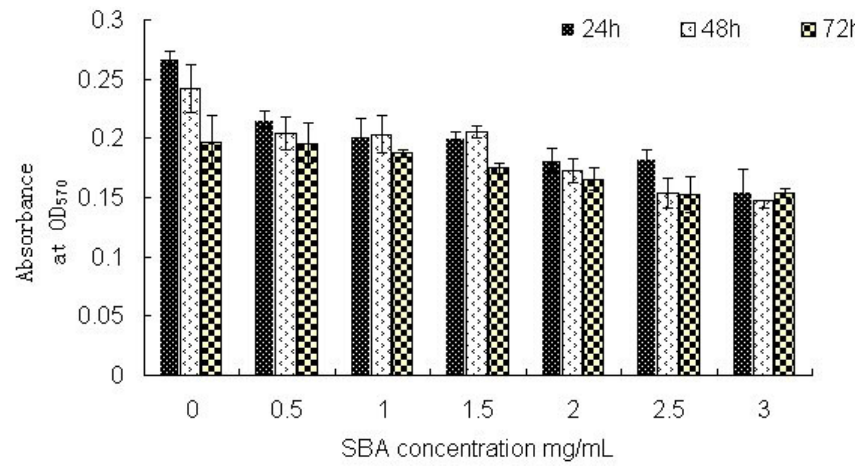
Figure 4. MTT assays showing the viability of IPEC-J2 cells after treatment with different concentrations of SBA for 24 h, 48 h, or 72 h. The data are the mean ± SD from 4 independent experiments and presented a significant decline trend ( p < 0.05). The control group was treated with 0 mg/mL SBA for the indicated times (24, 48, or 72 h). Treatment with 0.5, 1.0 or 1.5 mg/mL SBA resulted in a significant decrease compared with control ( p < 0.05), in addition, 2.0, 2.5 or 3.0mg/mL led to a significant decrease when compared with 0.5,1.0 or 1.5 mg/mL SBA treatment groups ( p < 0.05) (48 h or 72 h). However no significant differences were observed among 0.5, 1.0 and 1.5 mg/mL treatment, or between the 2.0 and 2.5 mg/mL SBA treatment ( p >